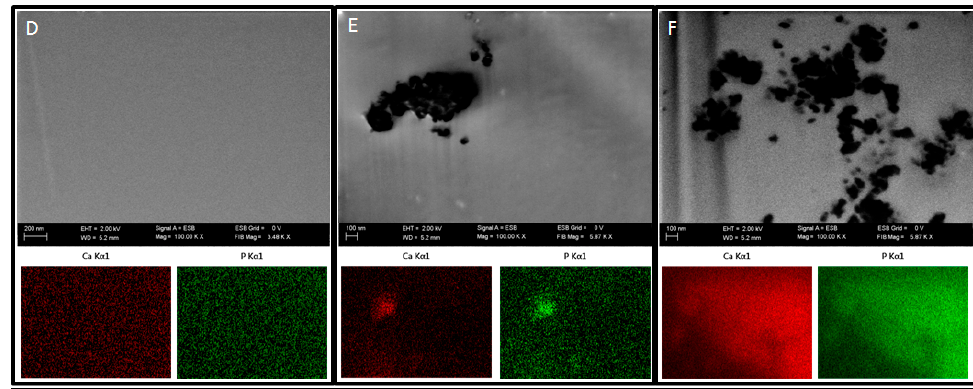
Figure 7. The presence of nHAp particles in the 80/20 (( A ) no nHAp added; ( B ) 10 wt % of nHAp added; ( C ) 20 wt % of nHAp added) and 20/80 (( D ) no nHAp added; ( E ) 10 wt % of nHAp added; ( F ) 20 wt % of nHAp added) blends, as revealed by FIB milling and imaging at 2 kV using EsB ® detector; colour images demonstrate the distribution of calcium (red) and phosphorus (green) in regions corresponding to SEM images; scale bars on each micrograph indicate 100,000× magnification.